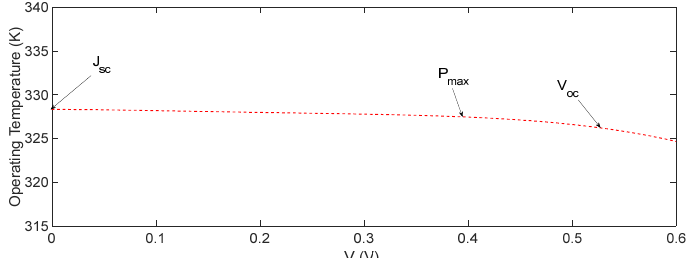
Figure 5. The simulated operating temperature of the OSC as a function of voltage. J sc , P max and 𝑉 (cid:3042)(cid:3030) marked by arrows.